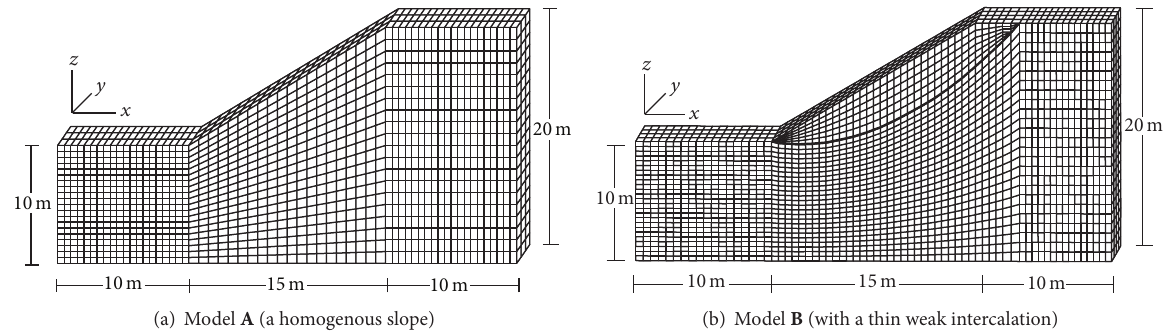
Figure 6: 3D finite difference mesh for Models A and B.